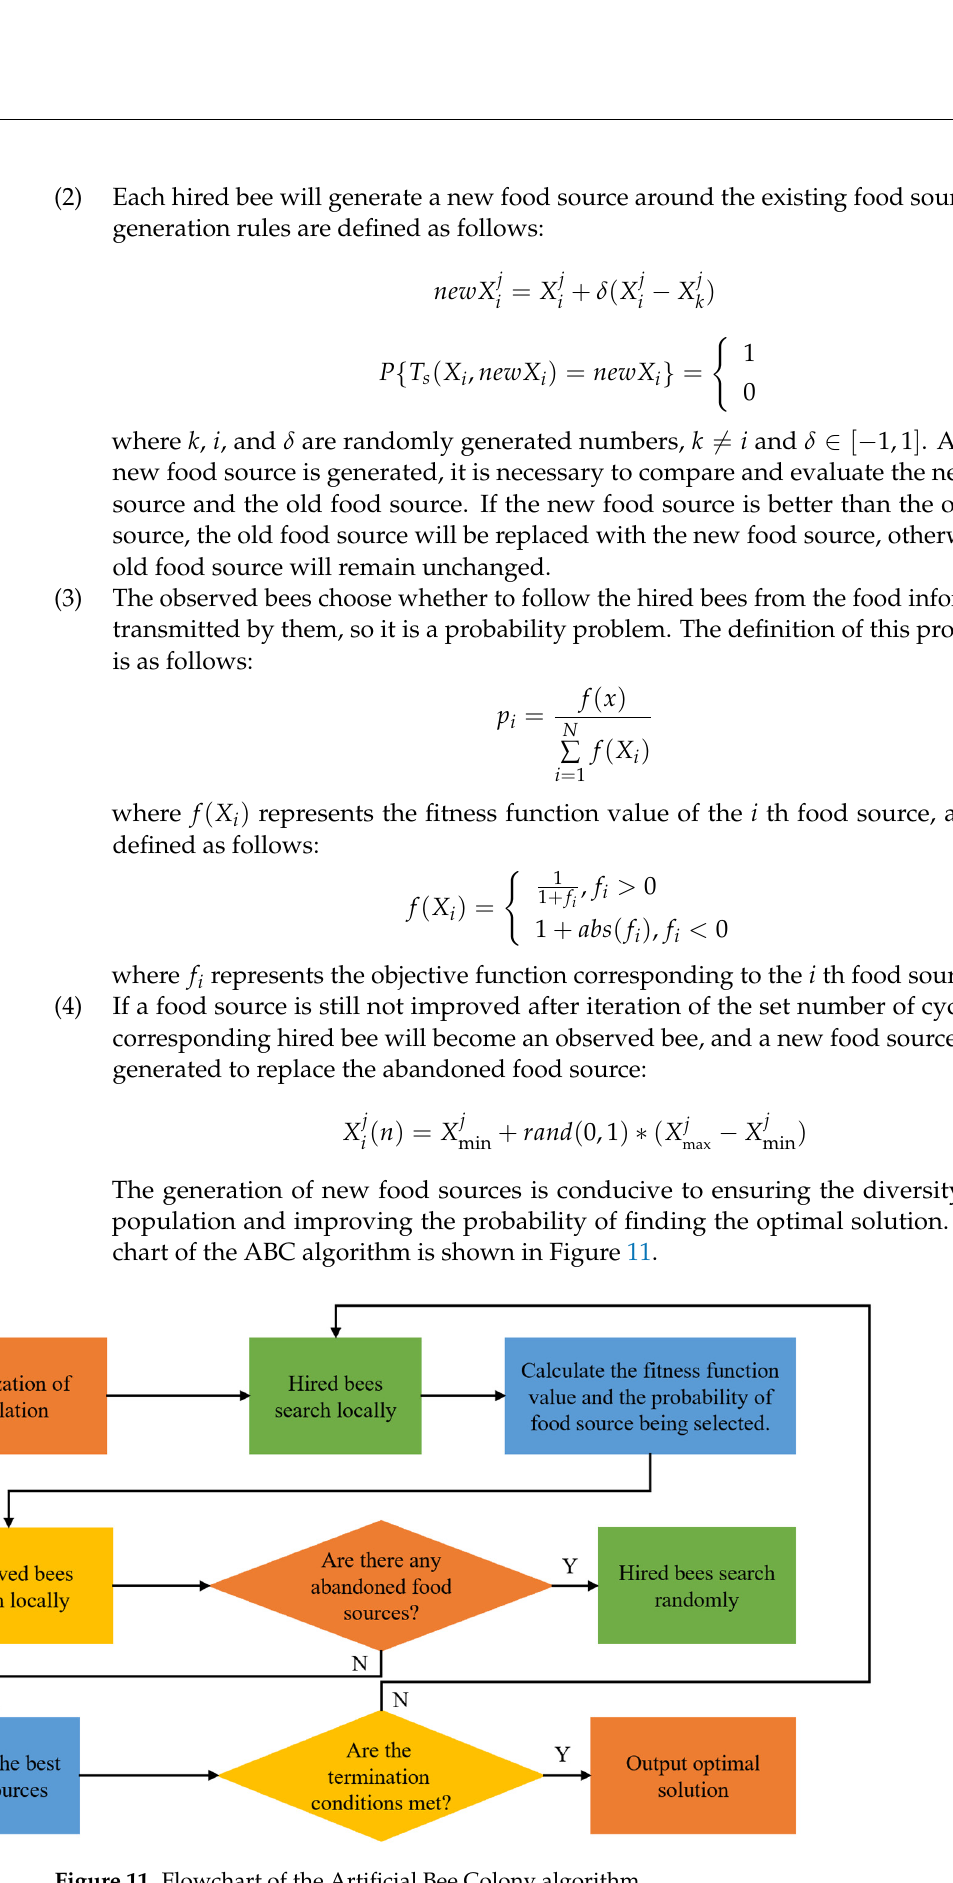
Figure 11. Flowchart of the Artificial Bee Colony